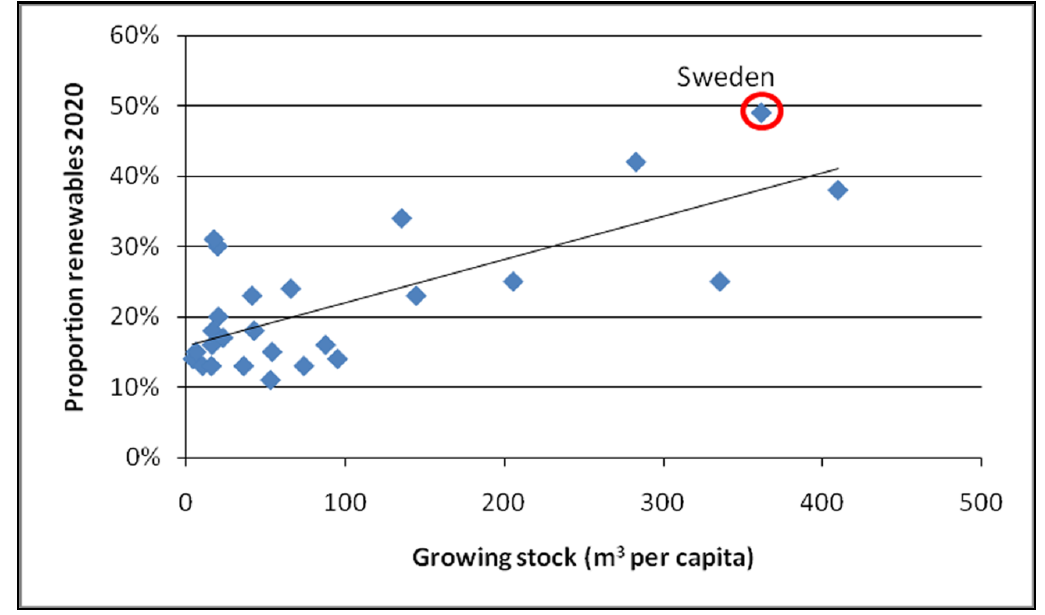
Figure 4. Relation between the growing forest stock per capita [6] and the targeted share of renewable energy sources in gross final energy consumption in 2020 for countries within the European Union [5] (R 2 = 0.52; p <